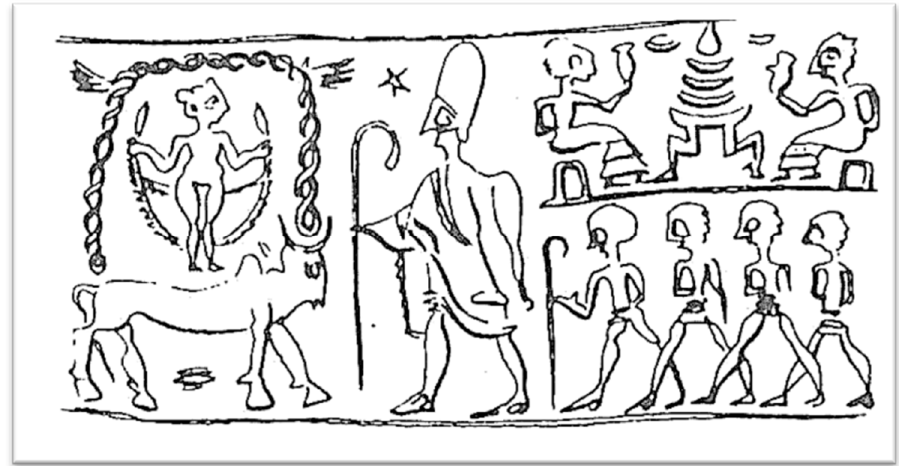
Figure 7. Syrian seal: Naked goddess on the back of a bull, lifting her skirt, under a winged guilloche (Amiet 1960: Figure 11).